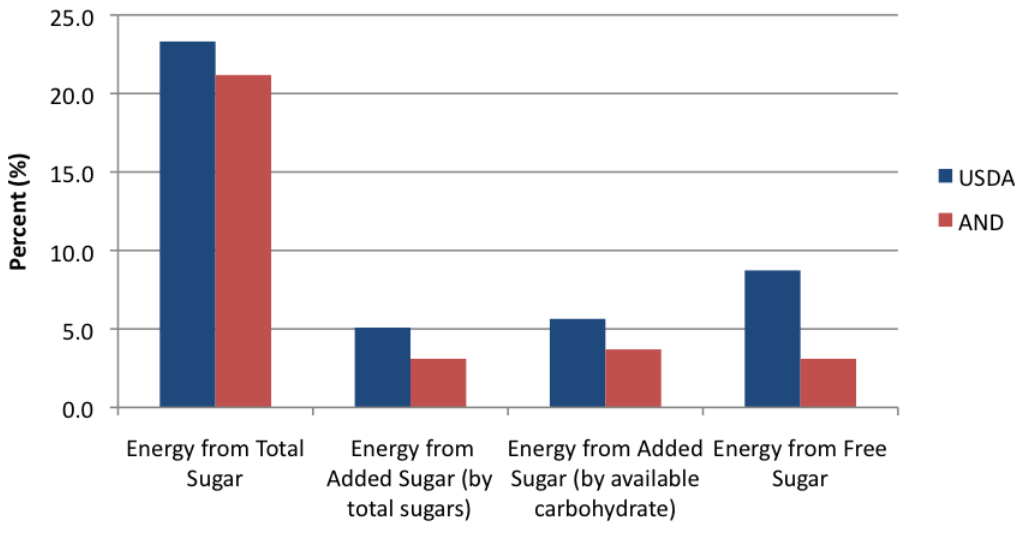
Figure 1. Average percent energy from total, added, and free sugar from sample menus designed by the United States Department of Agriculture (USDA) and the Academy of Nutrition and Dietetics (AND).